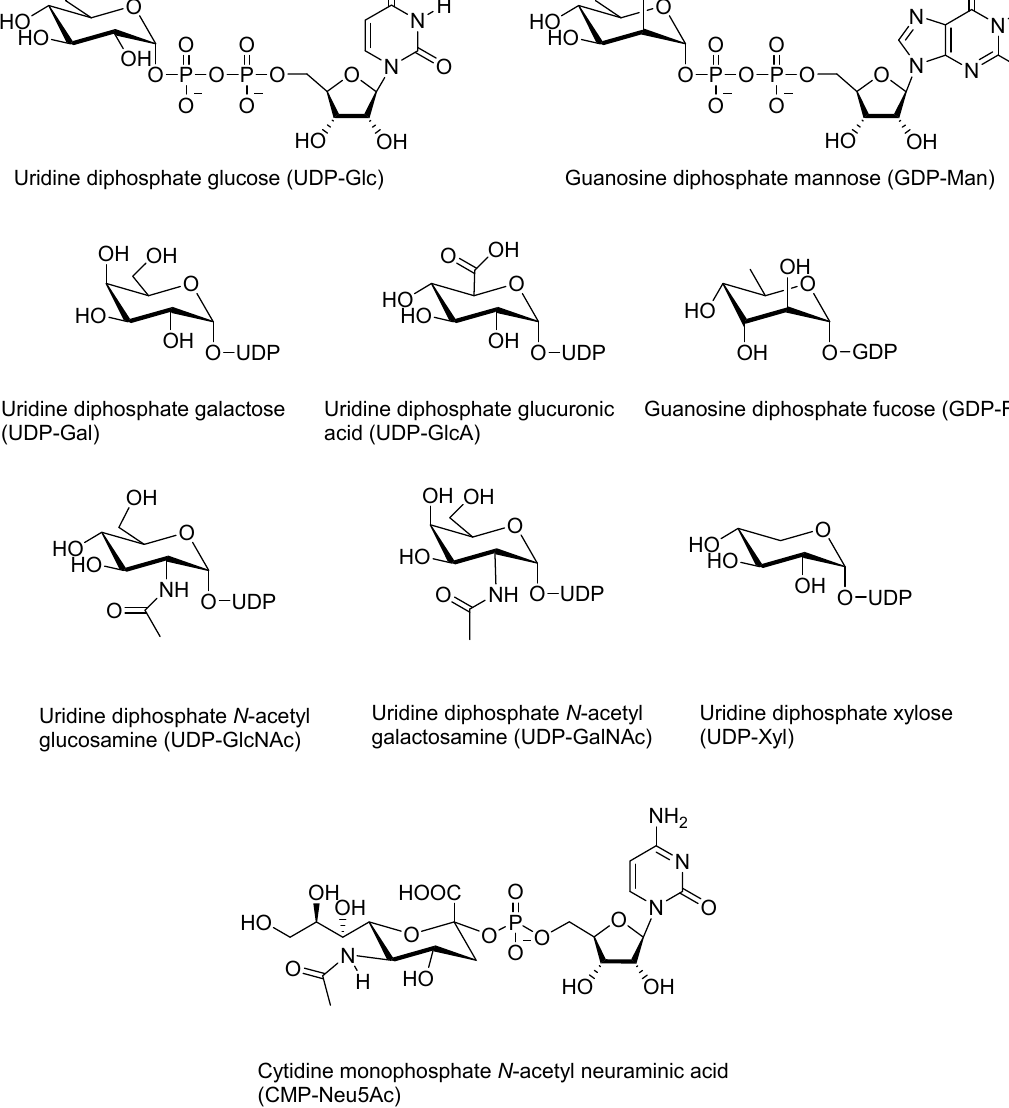
Figure 1. Structures of common nucleotide sugars found in human cells.